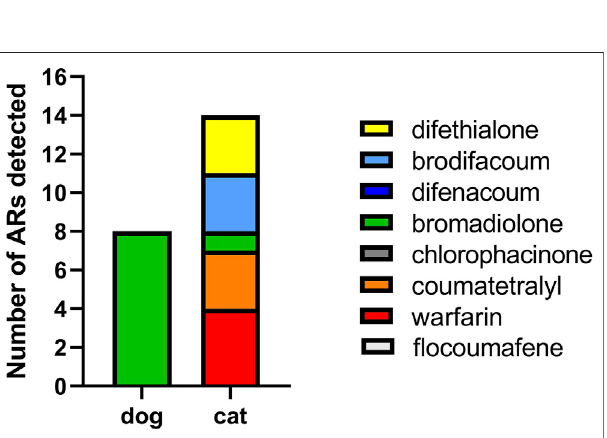
FIGURE2| Focusonthedogsamplecollectionarea( n =134)neartheFrenchtownofMontélimarintheDrômedepartmentwherethe8exposeddogswerefound, including fi ve in a limited area of only 20 km by 40 km.